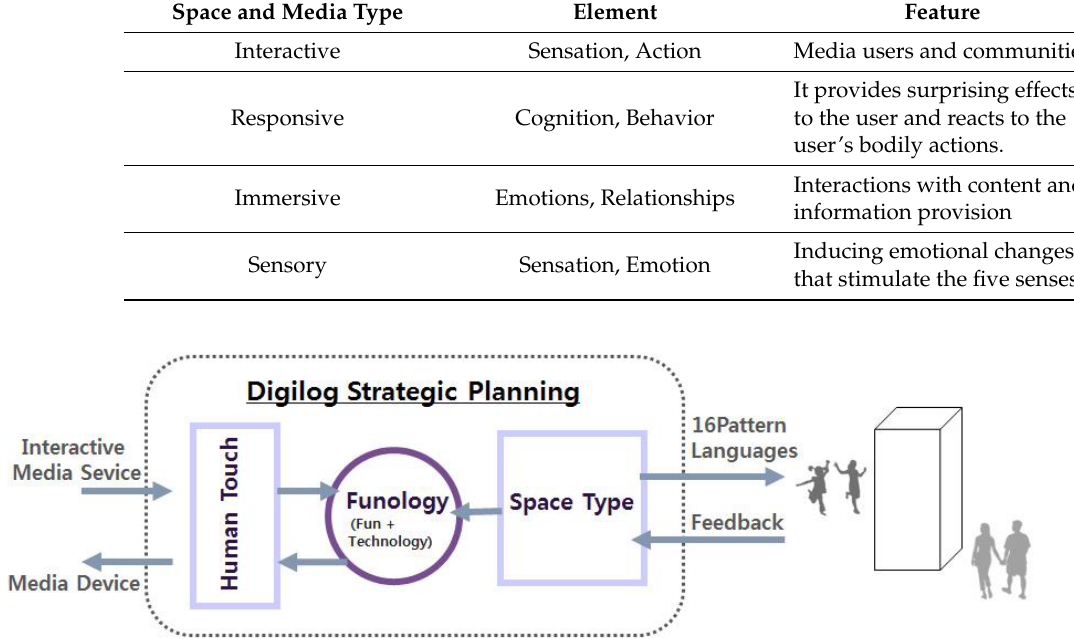
Figure 5. ICTs’ participatory media user interaction model included in Table 3.